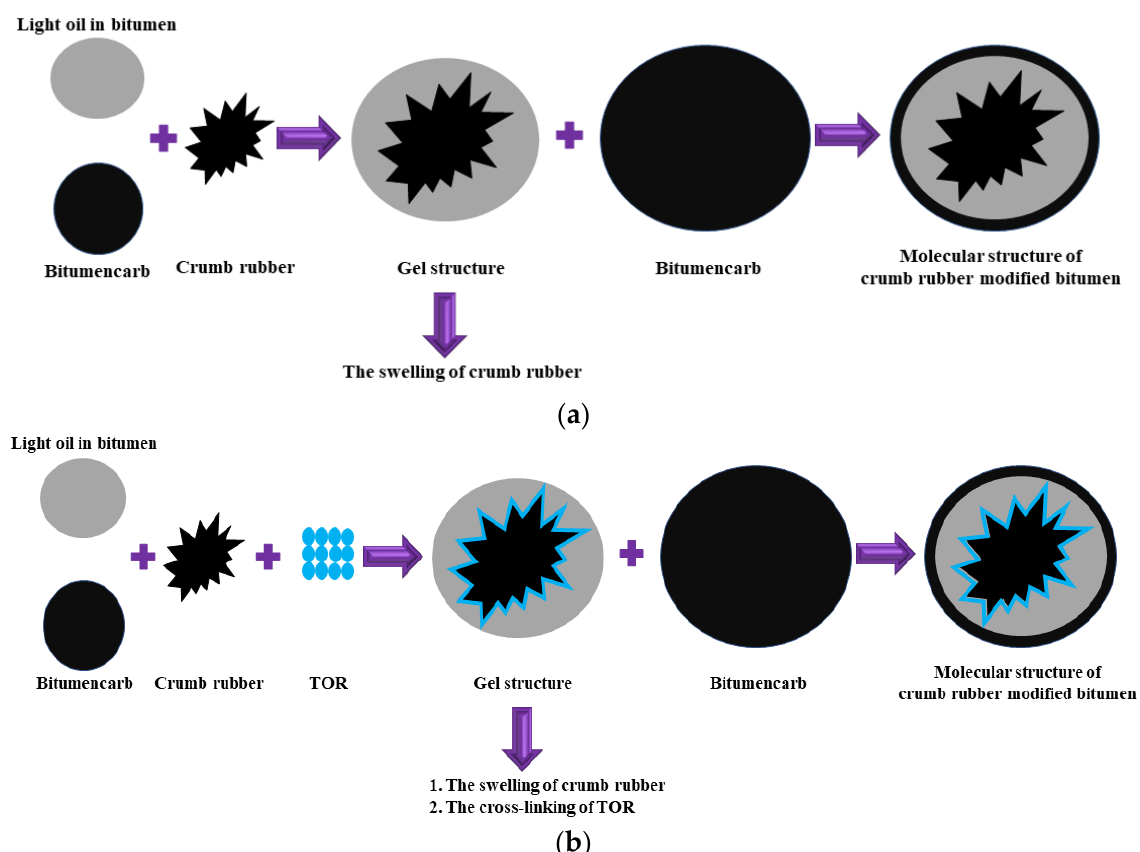
Figure 26. Schematic diagram of crumb rubber modified asphalt. ( a ) Schematic diagram of AR asphalt molecular structure. ( b ) Schematic diagram of TAR asphalt molecular structure.